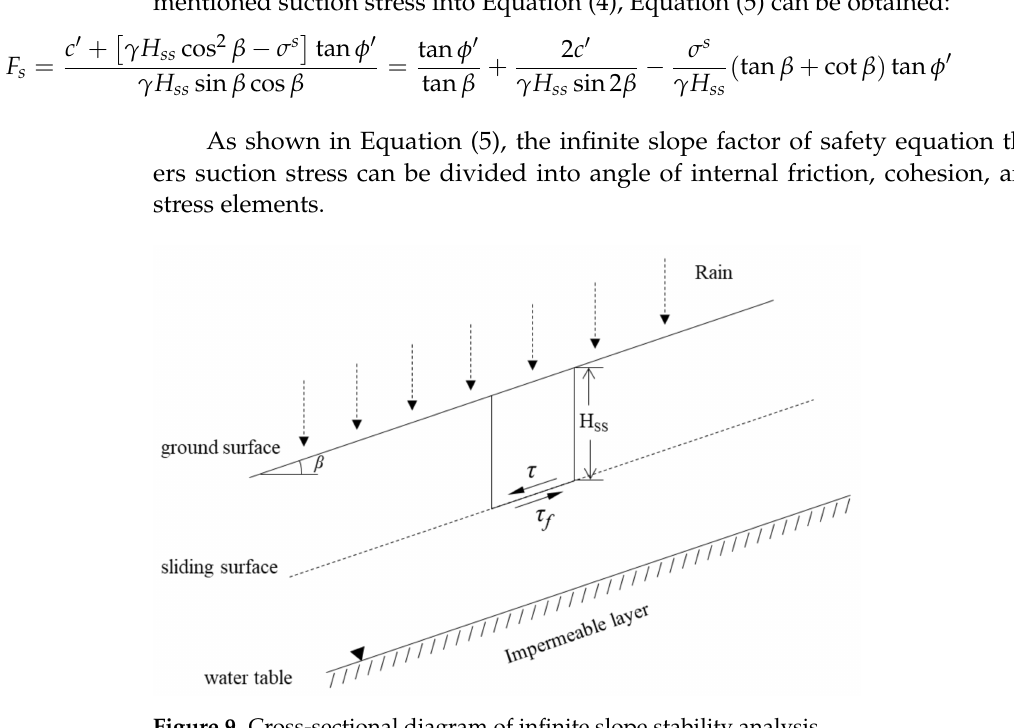
Figure 9. Cross-sectional diagram of infinite slope stability analysis.